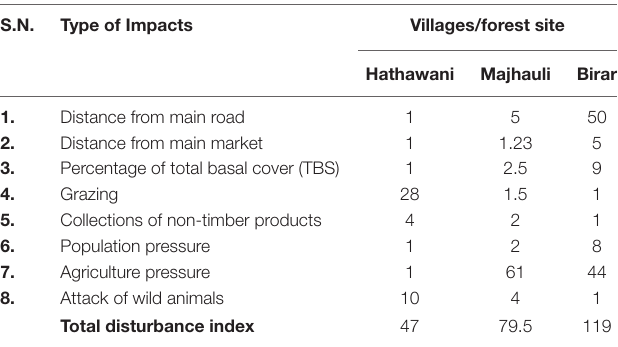
TABLE 1 | Scoring of disturbance factors (score for related impact) at each of the three dry tropical village/forest sites as highly disturb (HD), moderately disturb (MD), and low disturb